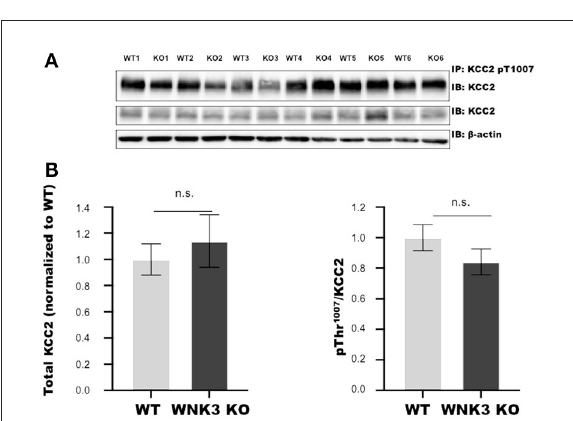
FIGURE2 WNK 3 KO mice cortex show no change in KCC2 pT1007 levels at postnatal day (P) 21 in comparison to WT littermates. (A) Immunoblots for pThr1007 KCC2 and total KCC2 protein levels following immunoprecipitation from postnatal day 21 cortex. Actin was used as a loading control. (B) Densitometric analysis for total KCC2 (left panel) and pThr 1007 /KCC2 (right panel) showed no significant differences between WT (Gray bars) and WNK3 KO (Black bars) at P 21. Intensities were normalized to WT levels. N = 6 mice in each group. Error bars represent